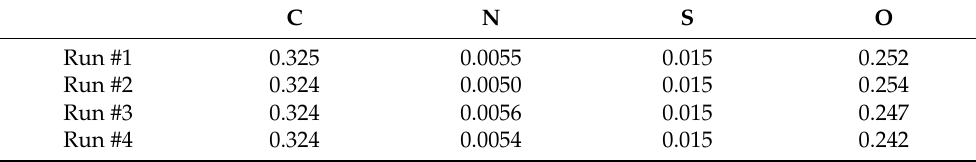
Table 1. Chemical composition (wt.%) of the W-4130 powder for each recycling set.